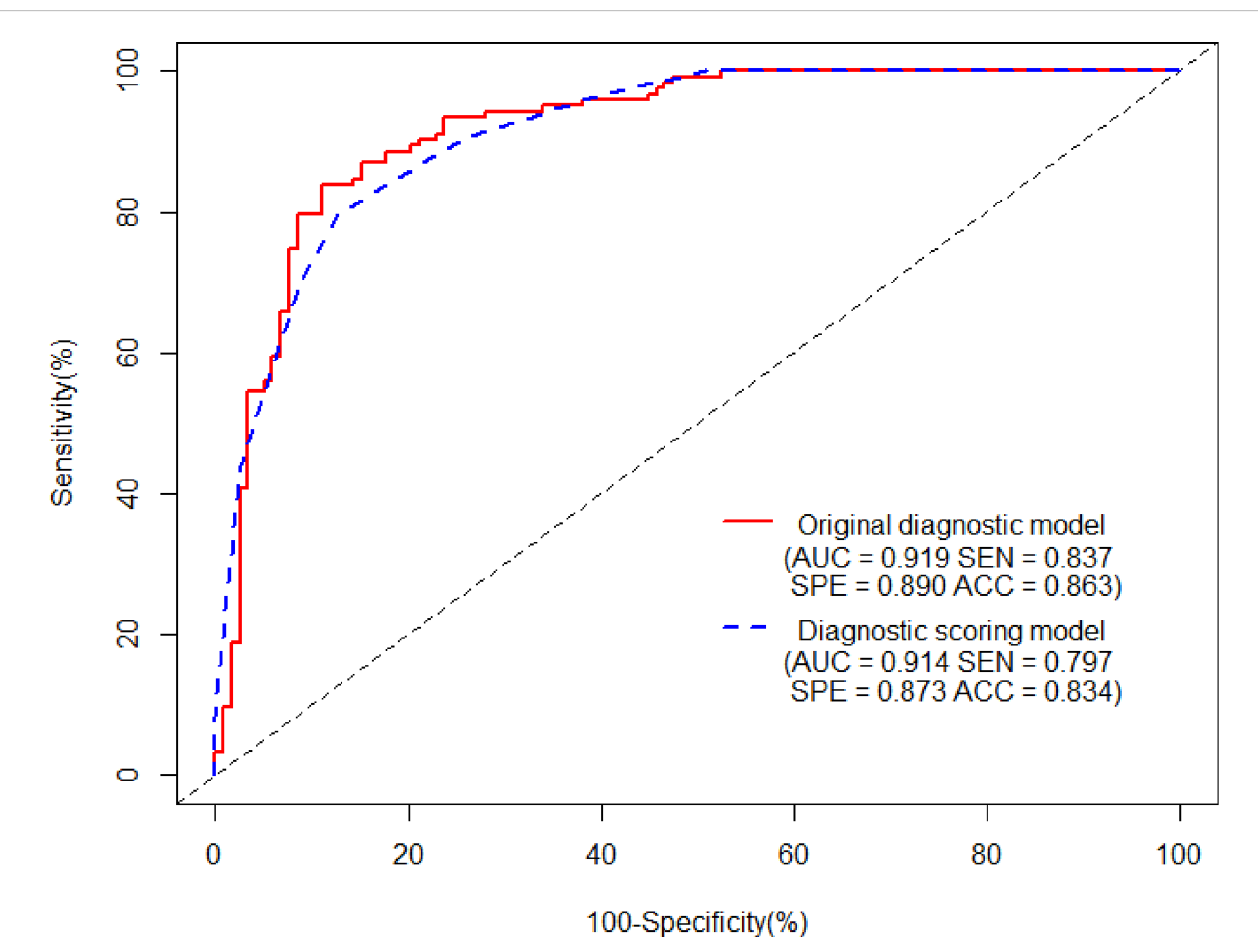
FIGURE 3 The AUCs of the original diagnostic model and the diagnostic scoring model for metastases were 0.919 (0.883 – 0.955) and 0.914 (0.880 – 0.948), respectively. There was no statistical signi fi cance of AUC between the two diagnostic model ( P = 0.644). As for the diagnostic scoring model, a cutoff value of ≥ 9 points yielded a sensitivity of 89.43% and a speci fi city of 76.27% for diagnosis of